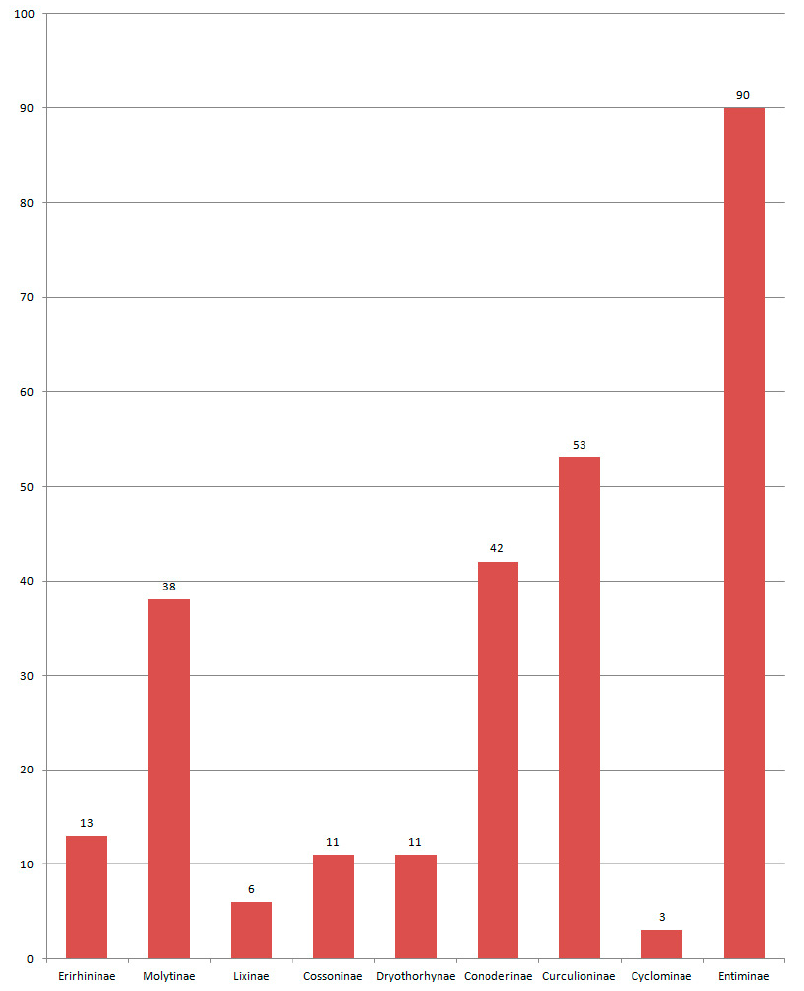
Figure 5. Composition of species of Curculionidae in the Eocene fauna.